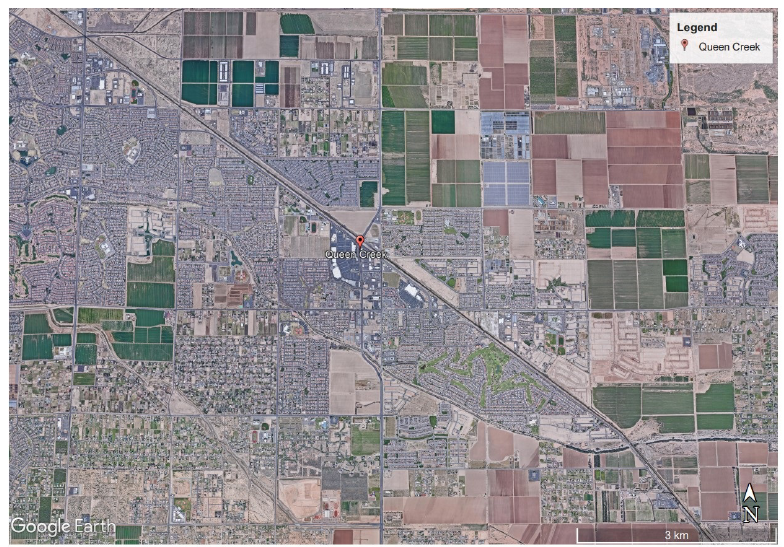
Figure 9. The town of Queen Creek, located to the SE of Phoenix—@2022 CNES/Airbus, Land- sat/Copernicus, Maxar Technologies, U.S. Geological Survey, USDA Farm Service Agency @